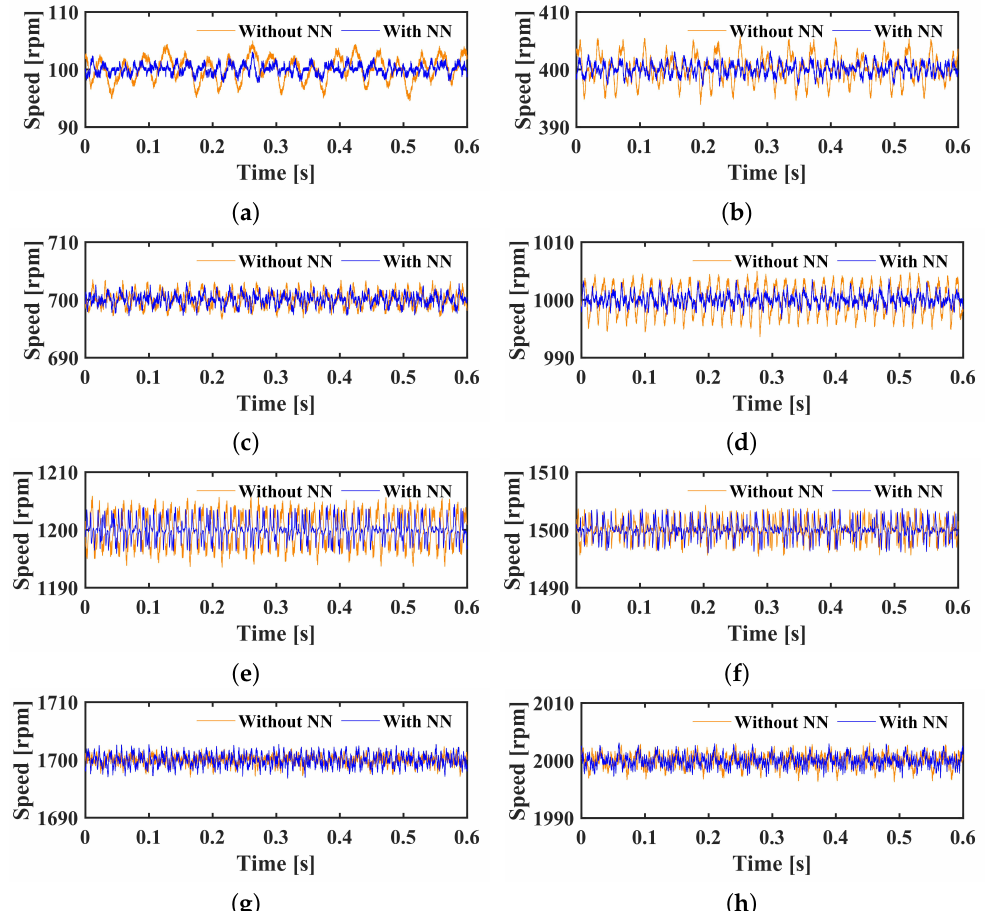
Figure 11. Speed ripple in conventional ESO-ADRC system and modified NN-ESO-ADRC system at the speed of: ( a ) 100 rpm, ( b ) 400 rpm, ( c ) 700 rpm, ( d ) 1000 rpm, ( e ) 1200 rpm, ( f ) 1500 rpm, ( g ) 1700 rpm, and ( h ) 2000